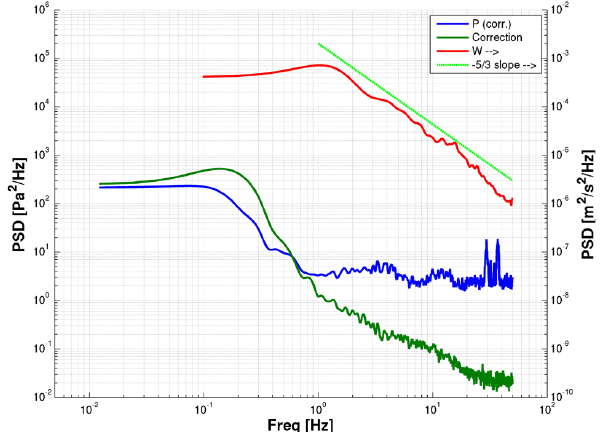
Fig. 14. Power spectral density as in Fig. 13 for period of sideslip angle changes at 7000m